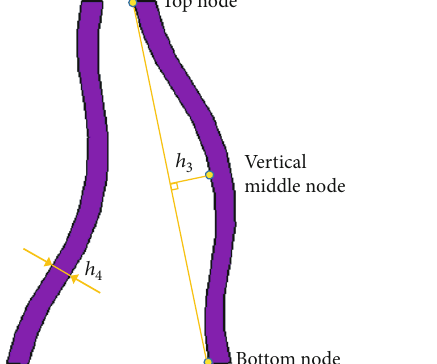
Figure 17: Flowchart of the design optimization Table 4: Schemes for the OA